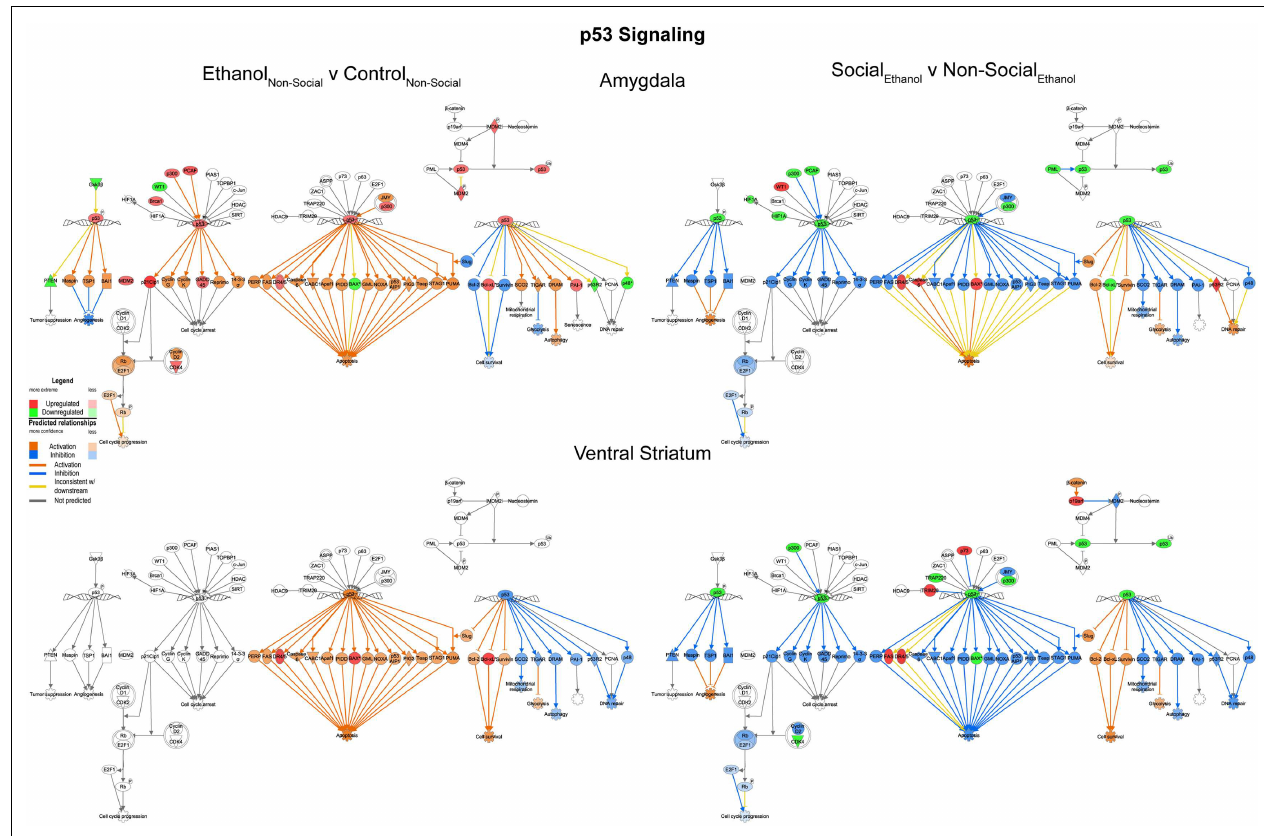
FIGURE 6 | Ethanol and social enrichment effects on nuclear p53 signaling . Conventions same as Figure 3 . Note that the changes in p53 signaling were highly similar in both brain areas following prenatal ethanol exposure (left), but showed differential responsiveness in the two brain areas following social enrichment